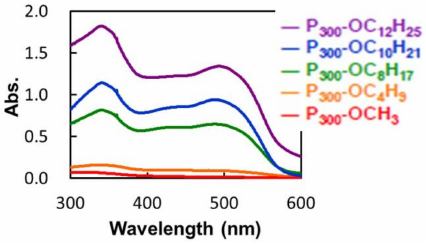
Figure 5. Absorption spectra at wavelengths of 300–600 nm when Sudan III was dissolved in polymer solutions with different carbon chain